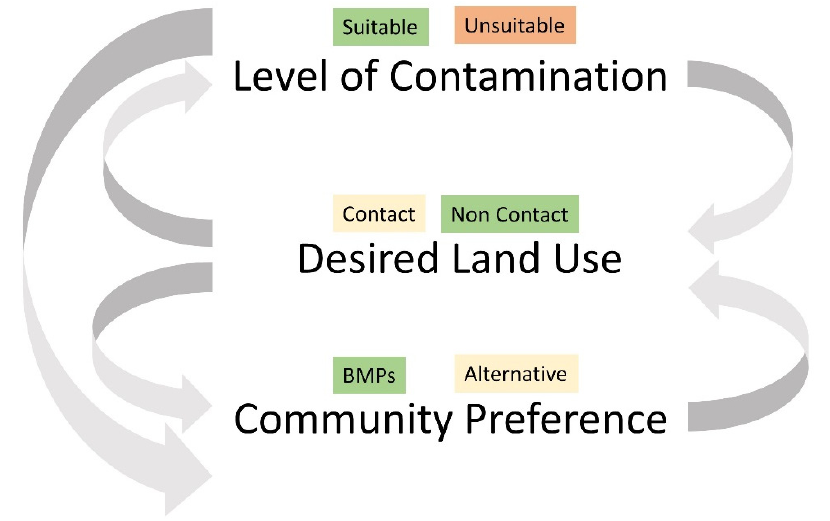
Figure 6. A framework for soil lead management. The framework considers: (1) the level of contamination; (2) the desired land use; and (3) the community’s preference in implementing that desired land use, and interactions among the variables. Level of contamination includes suitable and unsuitable, a distinction that the framework does not define, yet highlights the need for consistent soil lead guidelines to inform this decision. Desired land use is divided into contact (e.g., gardening and children’s play areas) and non-contact (e.g., landscaped) categories, which determine the amount of interaction between humans and soil systems. Community preference is divided into best management practices (BMPs) and alternatives.